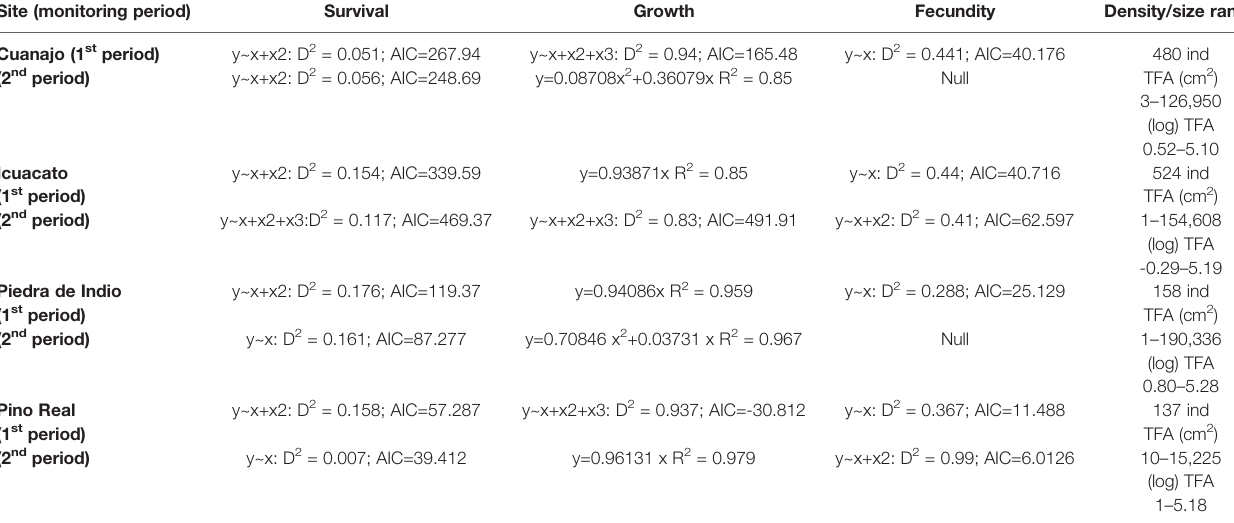
TABLE 1 | Models of the demographic processes used to construct IPM´s for the fi rst (1 st ) and second (2 nd ) monitoring periods ( fi rst and second consecutive years of the study, respectively). Site (monitoring period) Survival